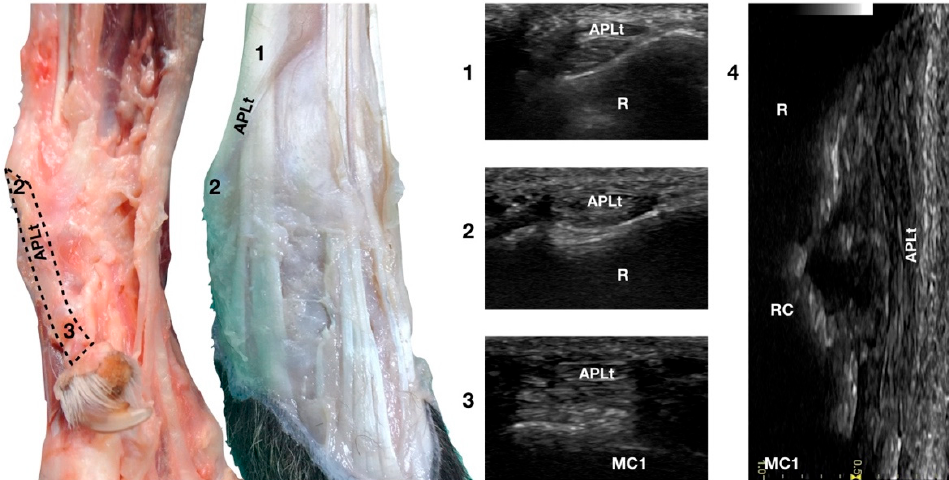
Figure 10. Palmaromedial and dorsal carpal faces. The oblique (1–2) and longitudinal (2–3) portions of the Abductor Pollicis Longus tendon are displayed. At the ulnar notch (2), after exiting the medial radial sulcus or the APL groove, the APLt changes inclination. Proximally, the APL follows the groove until the tenomuscular junction (1) crosses the ECRt beneath. At the ulnar notch, the oblique portion changes direction and exits the APL groove to become parallel to the medial surface of the carpus. It terminated at the base of the first metacarpal bone (MC1). On the longitudinal scan (4) obtained by aligning the probe to the medial margin of the ulnar notch, the thick APLt is seen as an undulating band rich in hyperechoic fibrillar lines. The radial (R), radiocarpal (RC), and first meta- carpal (MC1) surfaces beneath are visible.